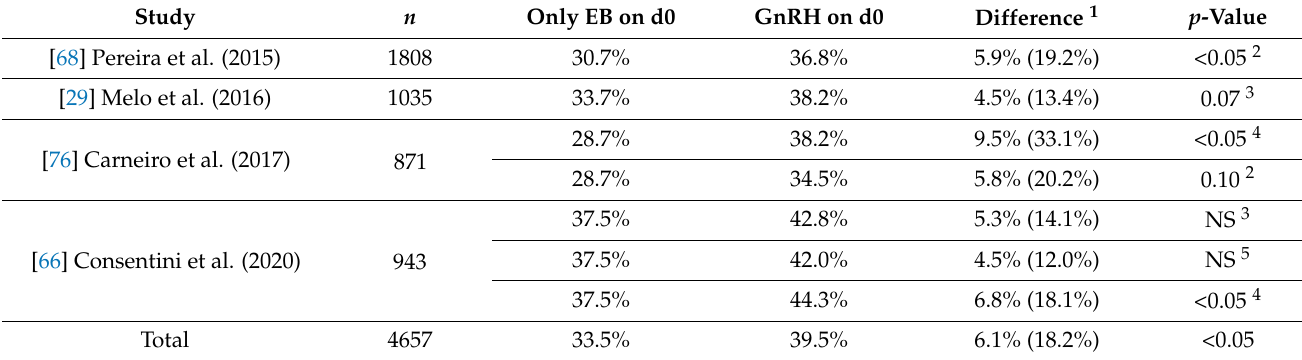
Table 2. Pregnancy per AI (P/AI) of lactating dairy cows submitted to timed artificial insemination (TAI) protocols initiating with estradiol benzoate (EB), gonadotropin releasing-hormone (GnRH), or including a GnRH at the beginning. In all treatments, a progesterone (P4) implant was inserted on